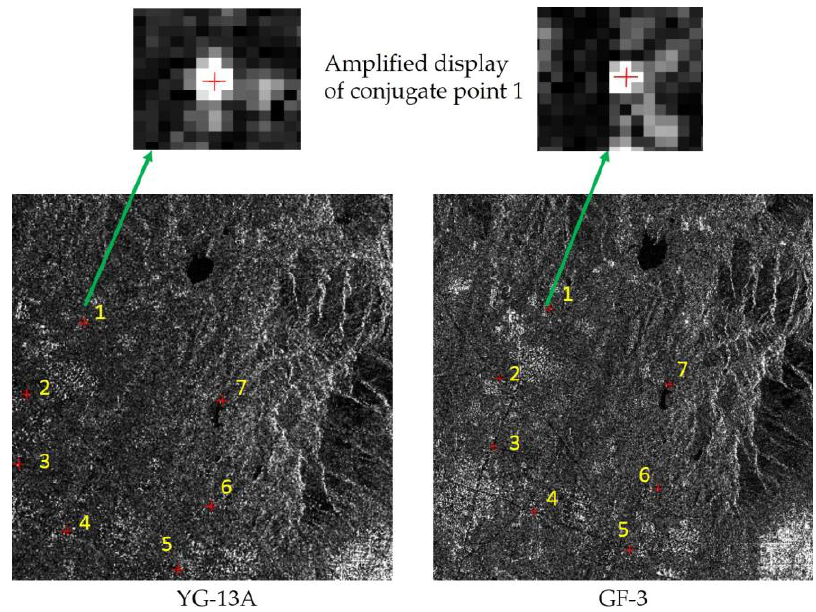
Figure 6. Distribution of conjugate points for cross-calibration image pair from the YG-13A ( left ) and Gaofen-3 satellites ( right ).